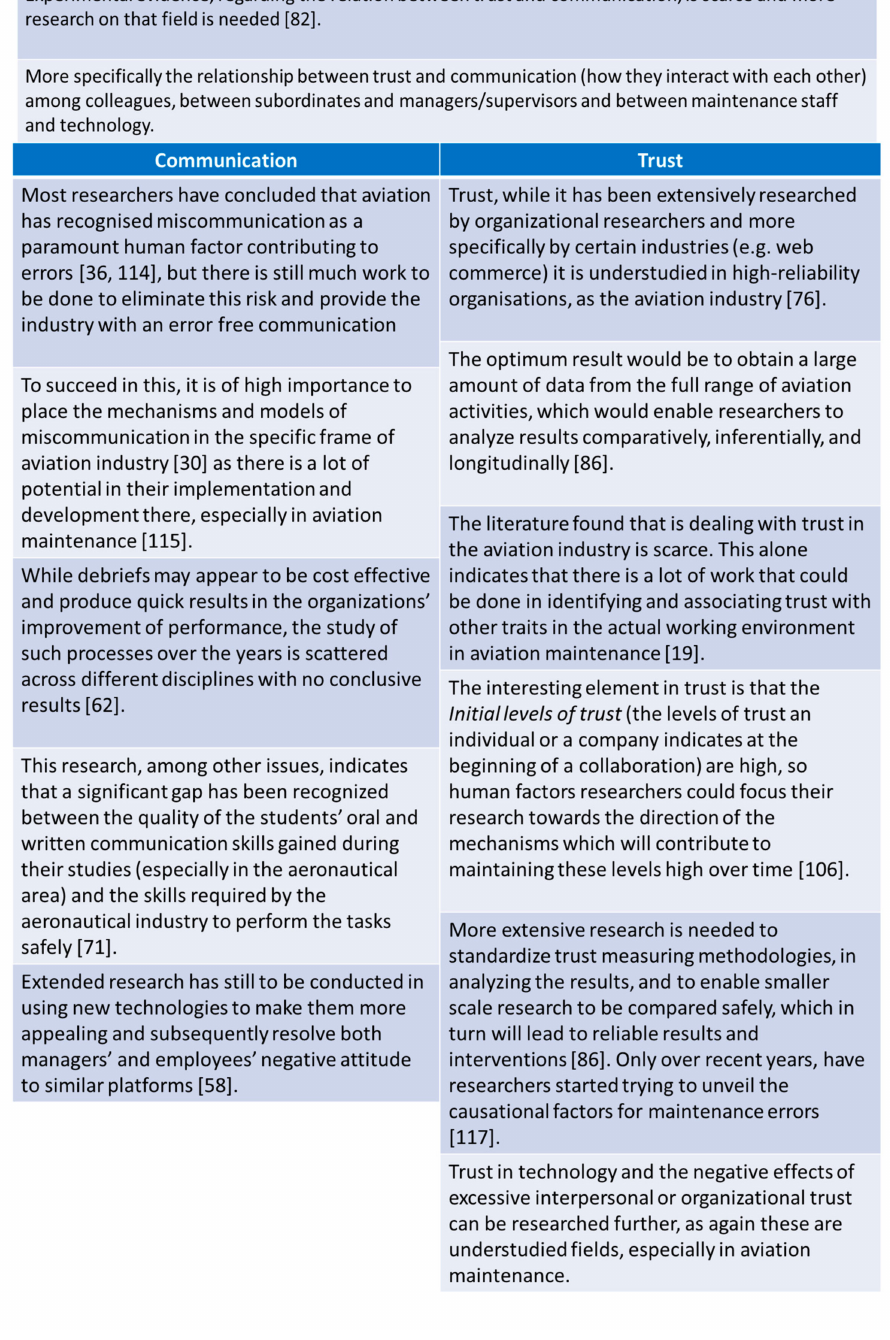
Figure 6. Tabular representation of the recognised future research